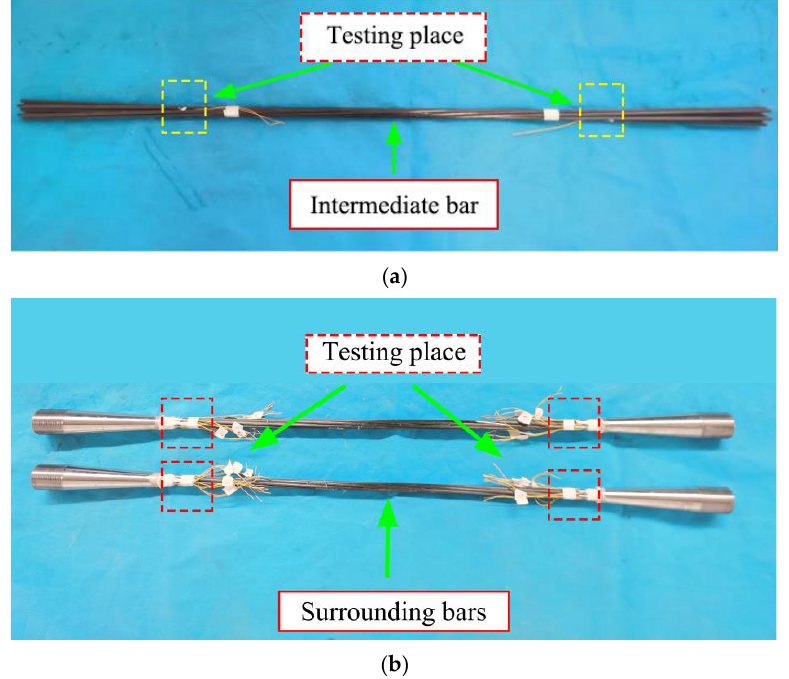
Figure 8. CFRP stranded wire measuring point layout. ( a ) Layout of measuring points in middle wire; ( b ) layout of the measurement points on each side wire.